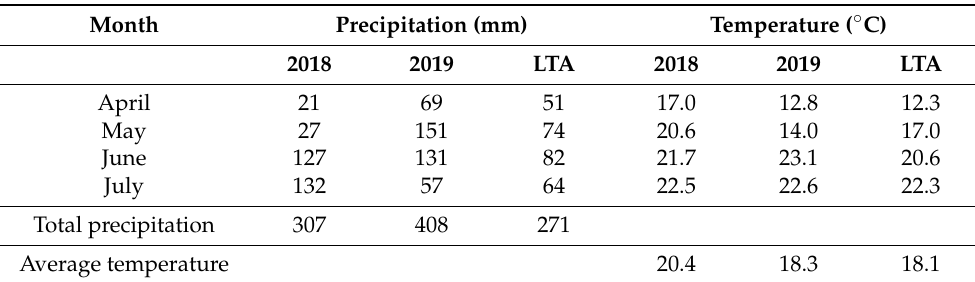
Table 1. Monthly climate data related to the evaluated sweet corn growing seasons and a long-term average from 1991 to 2020 (LTA) in Osijek, Croatia. Precipitation